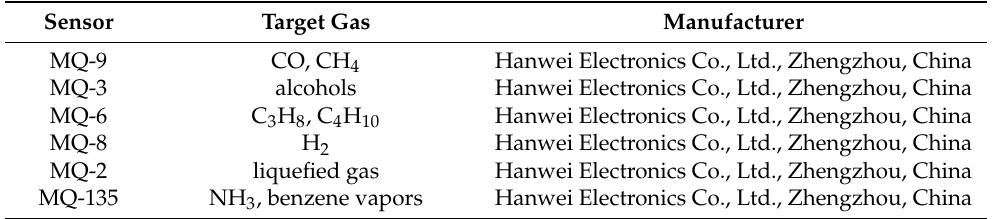
Table 2. Details of sensor.